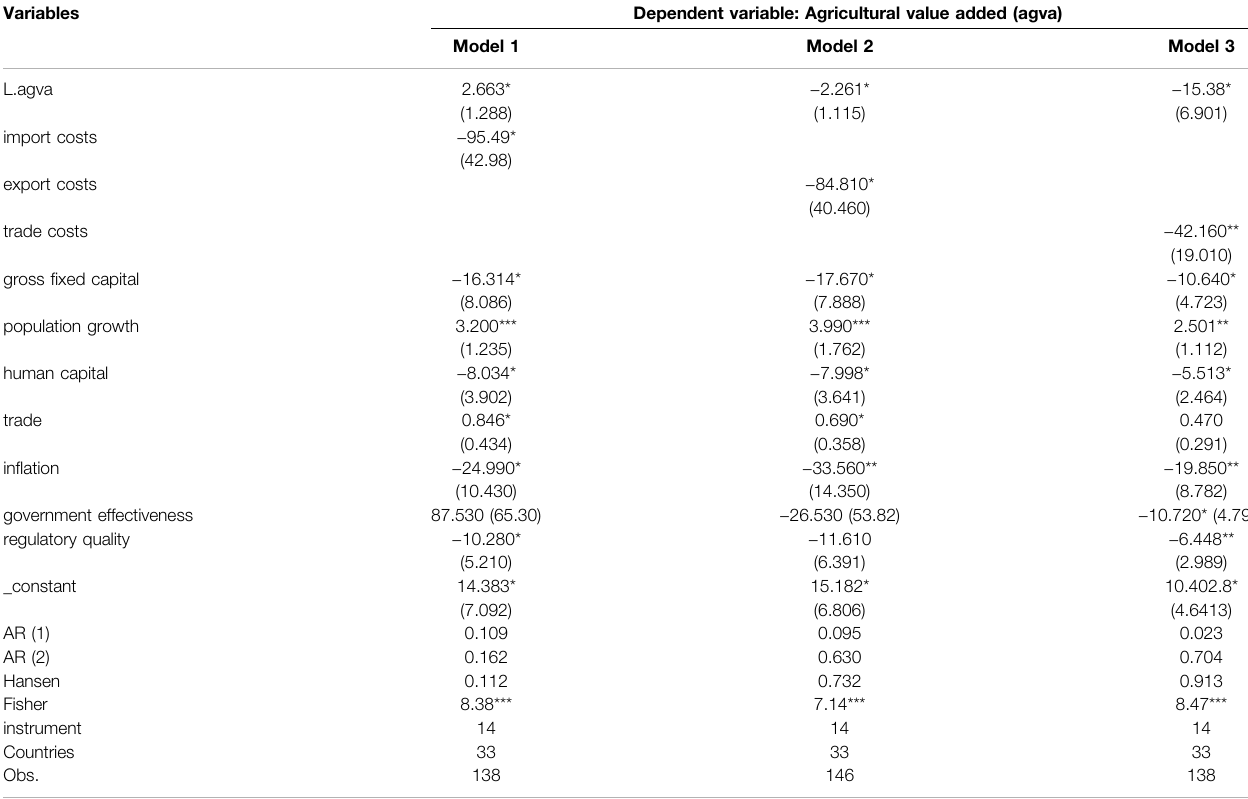
TABLE 8 | Robustness check using the annual % growth for the calculation of the agriculture value-added. Variables Dependent variable: Agricultural value added